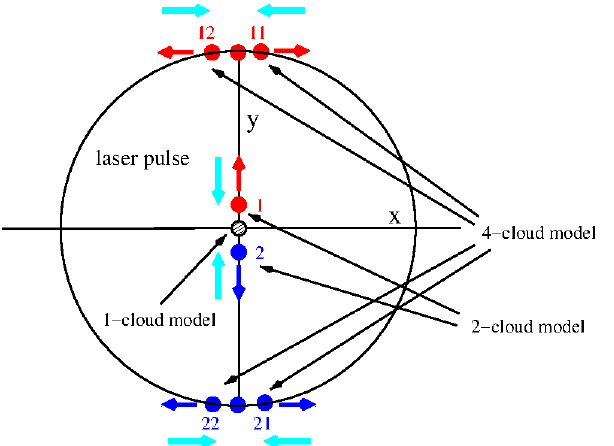
Figure 1. The Virginia dual Sagnac interferometer sequence as viewed from a non-rotating frame. A BEC (gray circle) is formed in an ideal harmonic trap ( ω x = ω y ≡ ω ⊥ ) at the trap center. First Split: laser pulses are used to split the BEC into two clouds that move at speed v B along the + y axis (cloud 1) and the − y axis (cloud 2), respectively. Second Split: At time t = t 1 cloud 1 at the top is split into clouds 11 and 12. Cloud 11 has a + v B ˆ i added to its velocity by the split while cloud 12 has − v B ˆ i added. These clouds move around a circular orbit in opposite directions. Cloud 2 at the bottom is split into clouds 21 and 22 that also orbit oppositely. Final Split: both of these cloud pairs are allowed to execute one orbit and, at time t = t 2 , when each pair of clouds re-overlaps, they are split in the same way as the Second Split. Each re-overlapped pair is split into four clouds: two overlapping clouds that are nearly motionless and two that continue orbiting in opposite directions. interferometer and the (21,22) cloud pair forms the “minus” ( − ) Sagnac